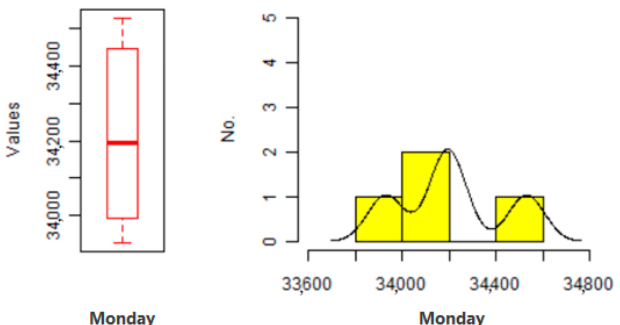
Figure 14. After a variance of excluding the noise data on Monday: In the graph, the vertical axis is the day of the week, and the horizontal axis is the traffic volume.